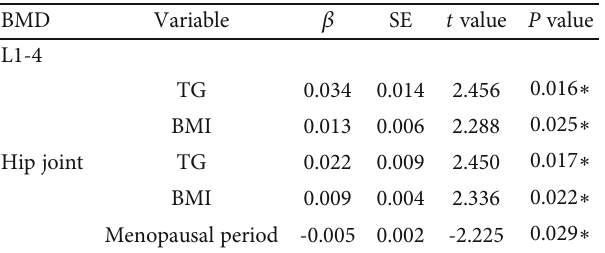
Table 5: Multivariate linear stepwise regression analysis of the in fl uencing factors of BMD in T2DM patients.